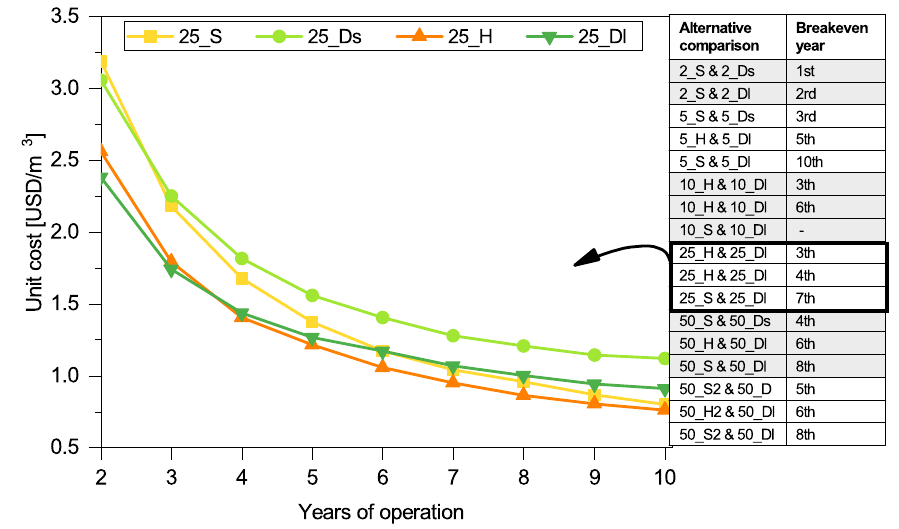
Figure 4. Unit costs (USD/m 3 ) of the 25 m 3 /h alternatives between 2 and 10 years of operation (left). On the right are the breakeven years for solar and short-running diesel (7 h), hybrid and long-running diesel (10/12 h) and solar and long-running diesel. Discount rate =